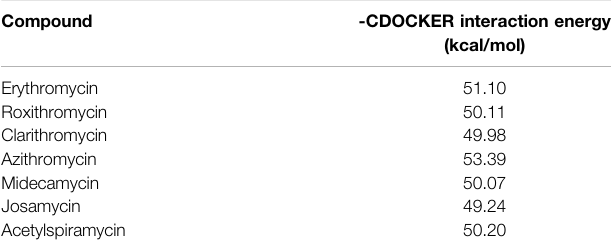
TABLE 1 | Docking scores of the highest -CDOCKER interaction energy for the selected macrolide antibiotics. Compound -CDOCKER interaction energy